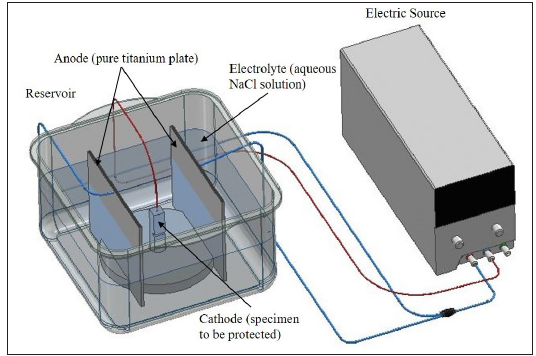
Figure 7. Cathodic protection apparatus.